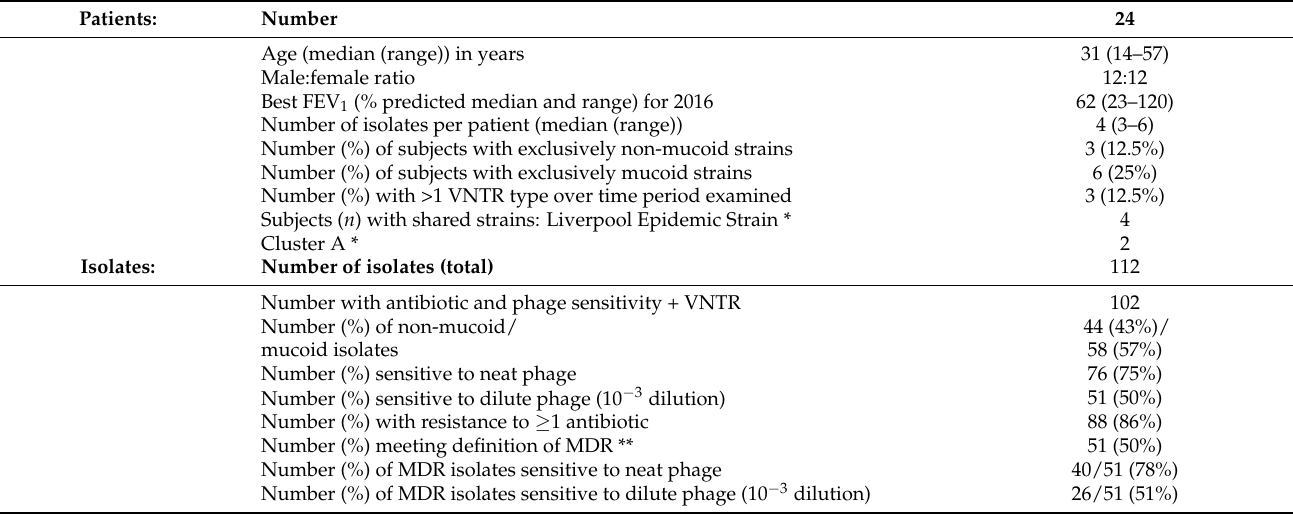
Table 1. Characteristics of the patients and